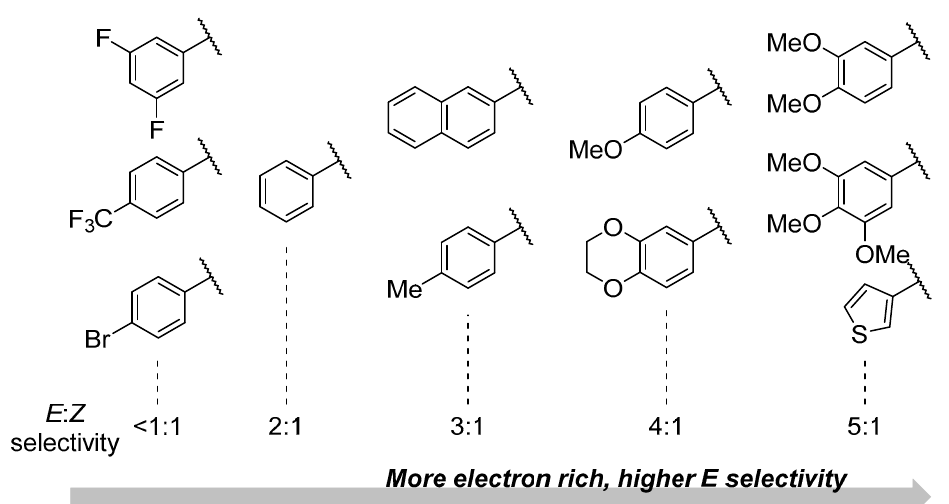
Figure 1. Correlation between the electronic properties of the alkynyl sulfone starting material and